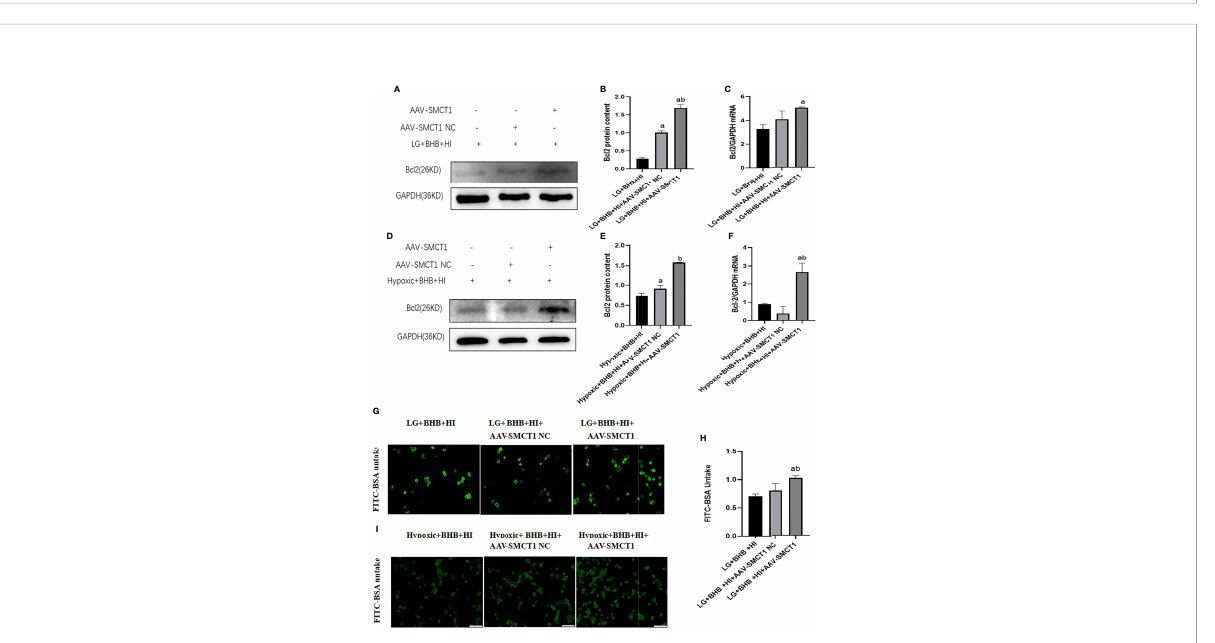
FIGURE 12 High insulin level inhibits BHB-induced protection on apoptosis and endocytic albumin production in HK2 cells under low glucose or hypoxic condition through SMCT1 in HK2 cells. (A, D) , Expression of Bcl-2; (B, E) Quantitative results of Bcl-2 proteins; (C, F) Quantitative results of Bcl-2 gene expression; (G, I) Changes of endocytosed albumin detected by fl uorescence microscopy; (H) Changes of endocytosed albumin detected by a microplate reader. In panels (B, C, H) a p < 0.05 compared with the LG+BHB+HI group; b p < 0.05, compared with the LG + BHB + HI + AAV-SMCT1 NC group; in panels (C, F) a p < 0.05, compared with the Hypoxic + BHB + HI group; b p < 0.05, compared with the Hypoxic + BHB + HI + AAV-SMCT1 NC